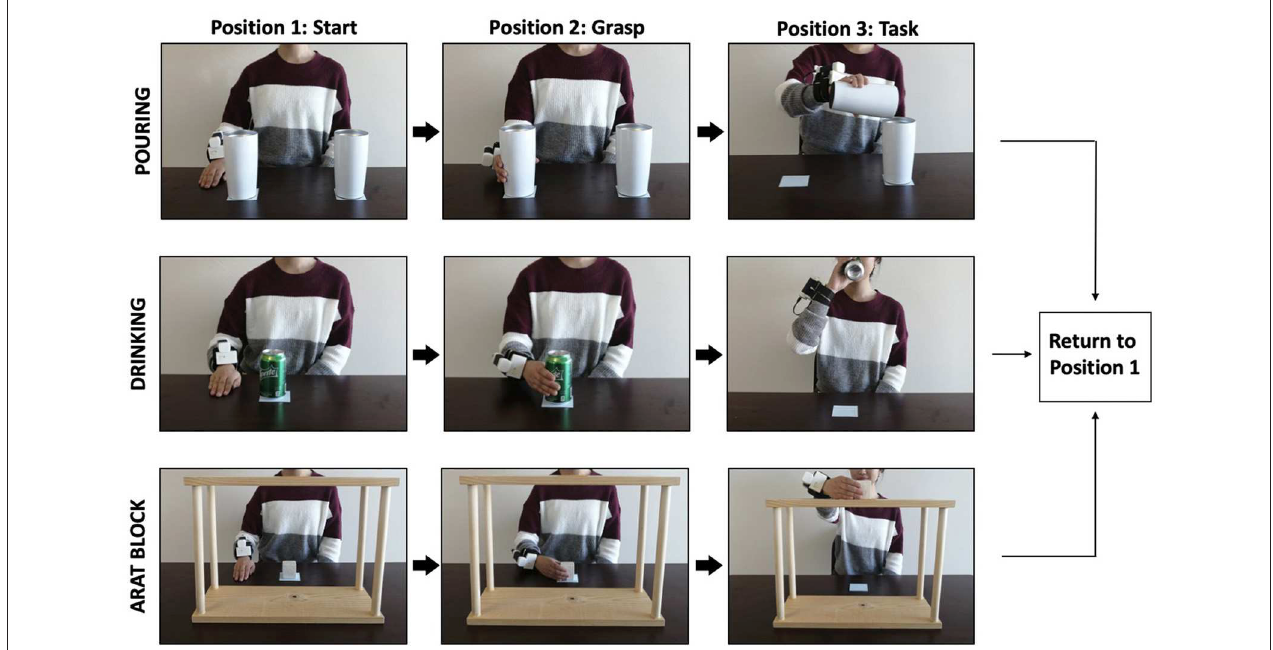
FIGURE 2 | Example of a participant executing the pour water (top panel) , drink (middle panel) , and block task (bottom panel) while wearing the outREACH sensor.